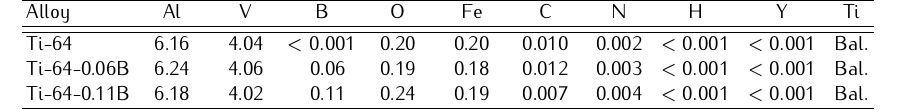
Table 1. Chemical compositions (in wt%) of cast Ti-64 alloy and its variants investigated in the current work Alloy